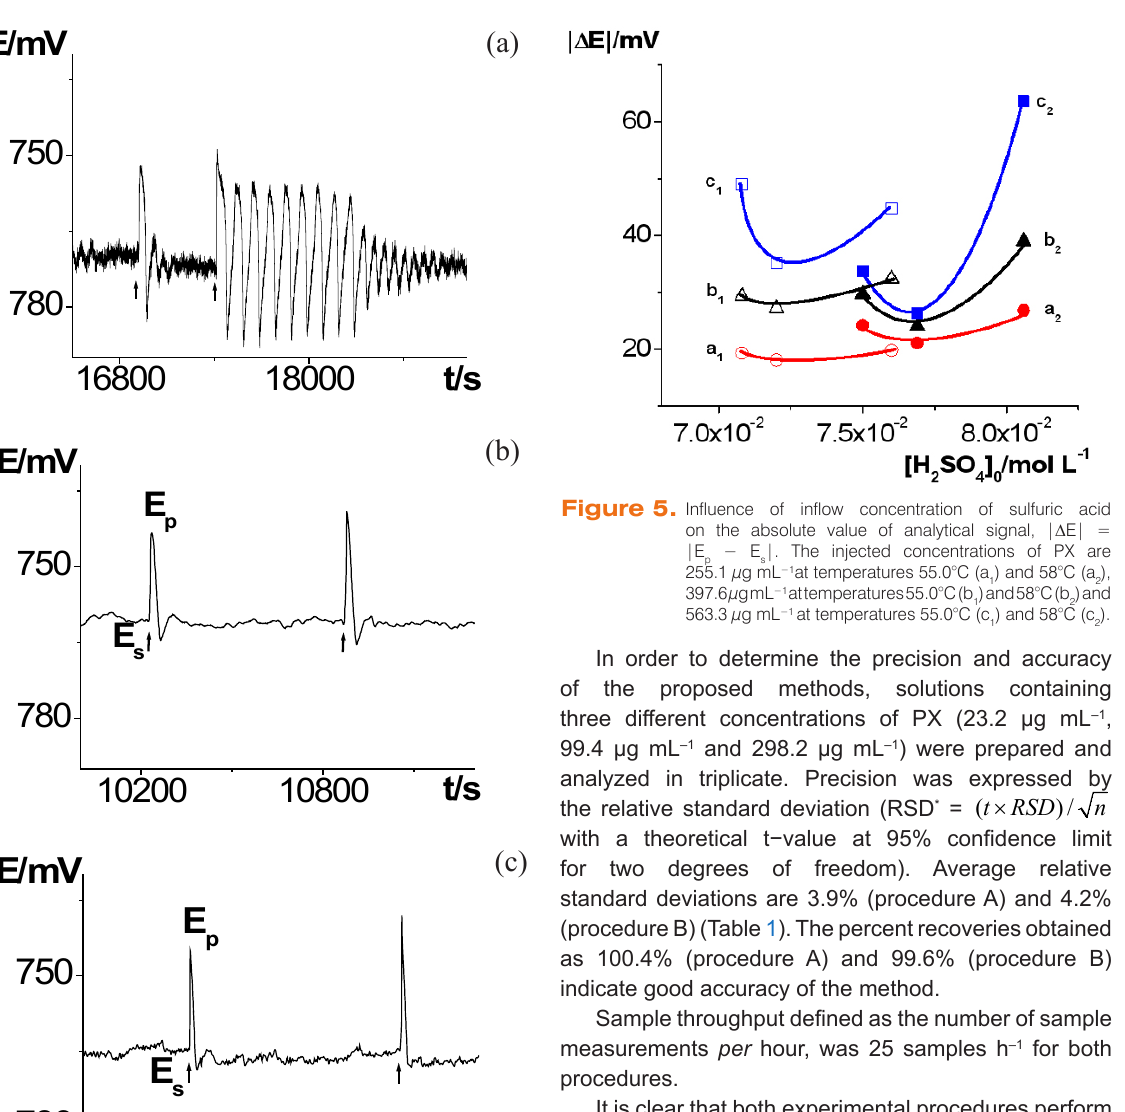
obtained after its perturbation in the stable stationary state in vicinity of BP at T = 58°C (see Fig. 2) and different B acidities: [H SO ] = 7.50×10 –2 mol L −1 (a), [H SO ] = 2 4 0 2 4 0 7.69×10 –2 mol L −1 (b) and [H SO ] = 8.06×10 –2 mol L −1 2 4 0 (c). Arrows indicate the moments at which (from left to right) 96.1 µg mL −1 and 255.1 µg mL −1 of PX was injected, respectively.